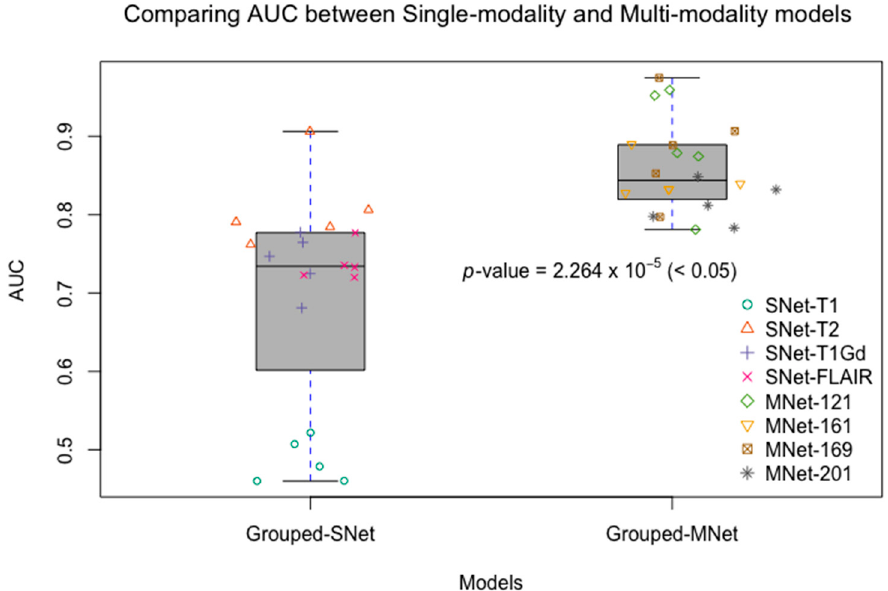
Figure 5. Comparing AUCs between single-modality and multi-modality models. Grouped-SNet: grouped single-modality models, Grouped-MNet: grouped multi-modality models. We grouped the results of five-fold cross-validation from all single-modality models as Grouped-SNet, and also grouped the results of five-fold cross-validation from all multi-modality models as Grouped-MNet. The student’s t -test result comparing Grouped-SNet and Grouped-MNet is statistically significant.